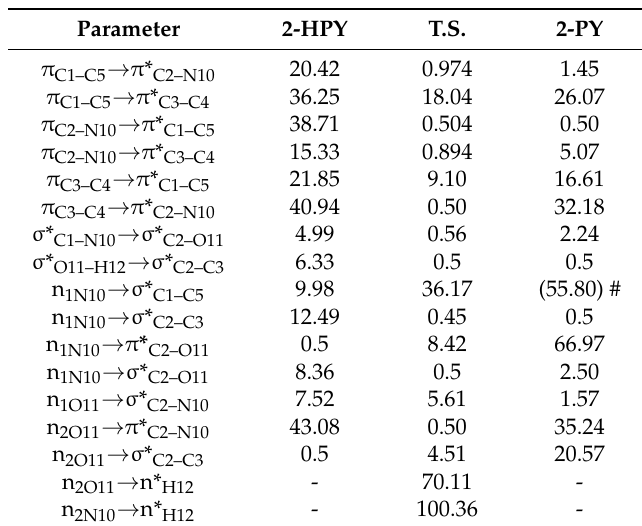
Table 5. Second order perturbation (E (2) ) computation of the delocalization energies (kcal/mol) of 2-HPY, the transition state (T.S.) and 2-PY which were estimated by using CAM-B3LYP/aug-cc-pvdz level of